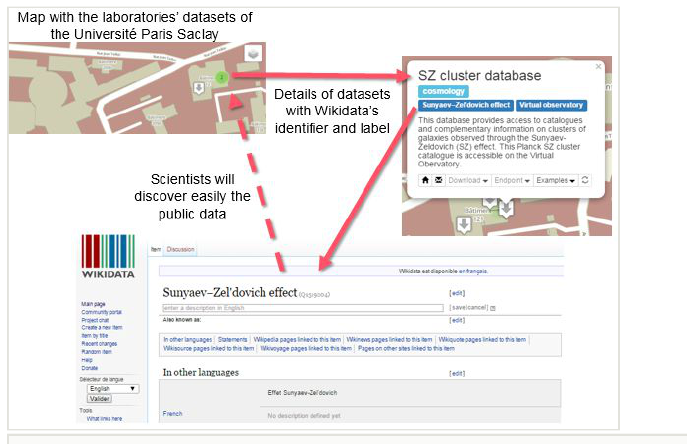
Figure 2. Prototype of the platform at the Center for Data Science of Paris-Saclay, where Wikidata identifiers are already used to link public data and public research